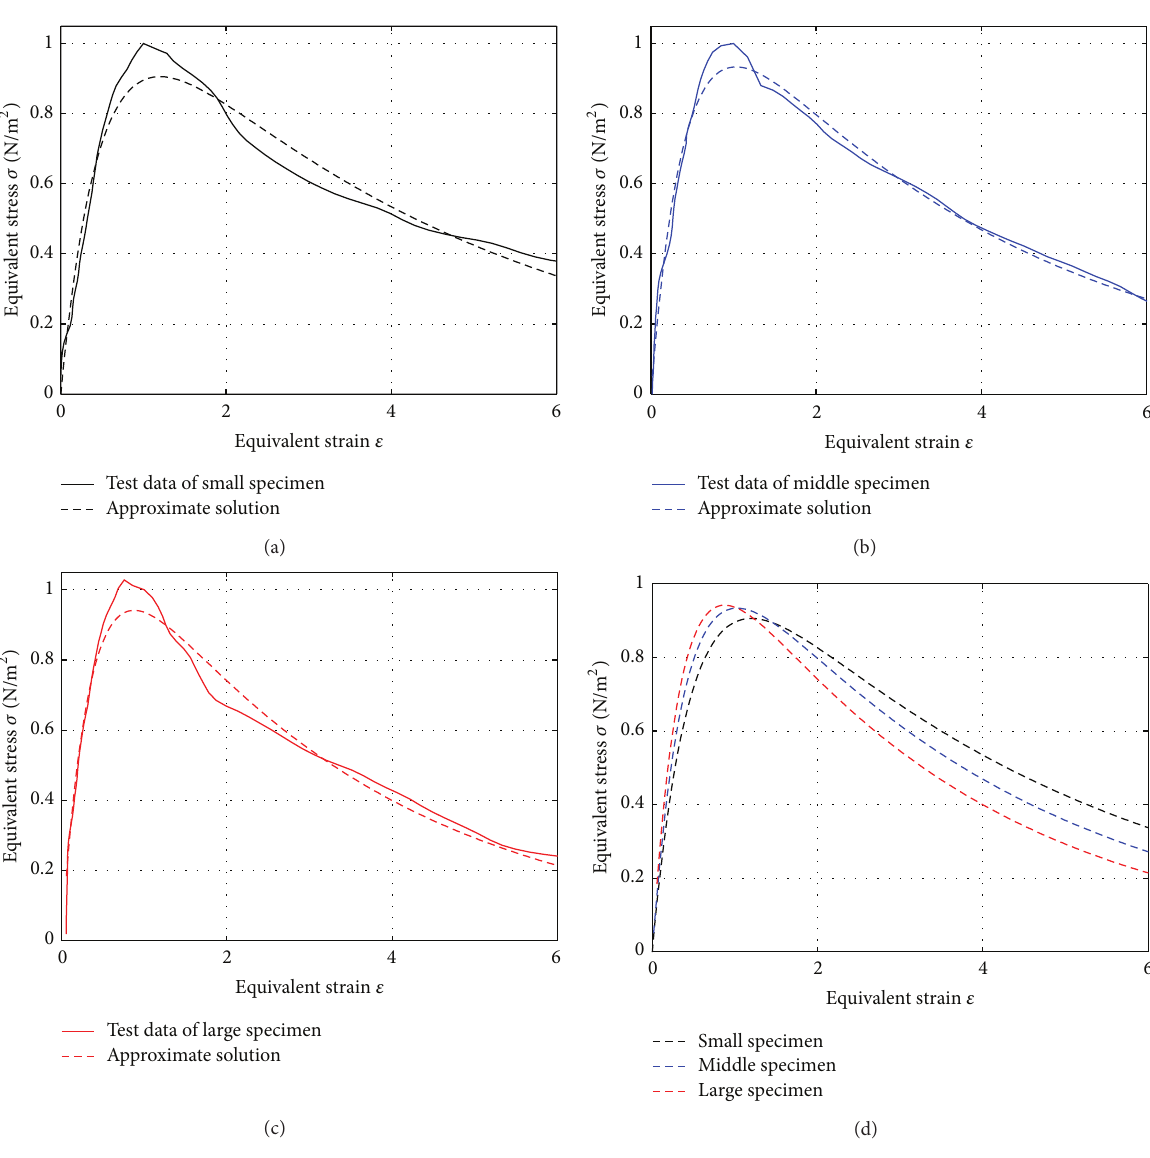
Figure 14: Stress-strain curve comparison of test value and approximate